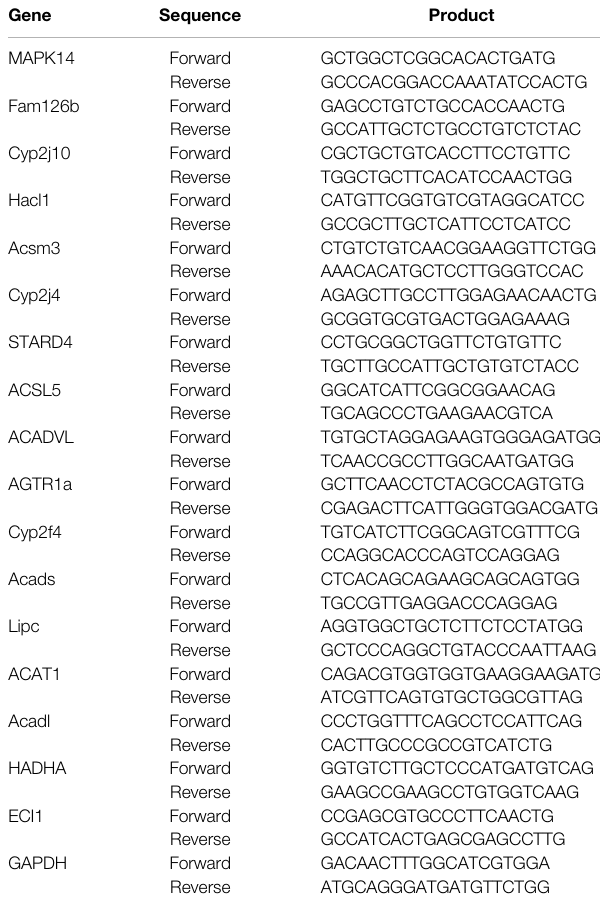
Table 1 | The primer sequences of the hub